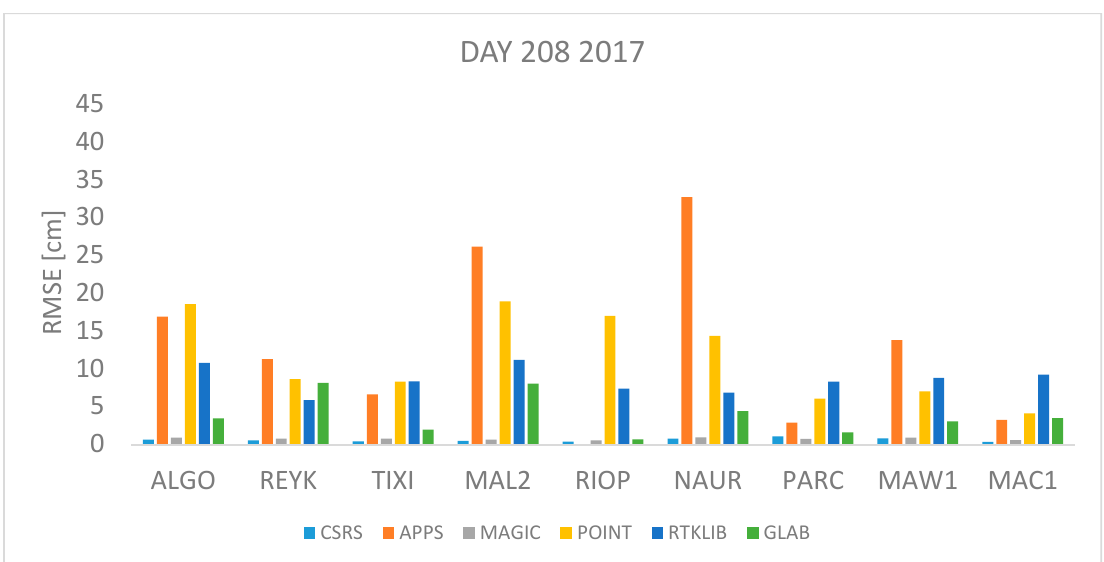
Figure 6. RMSE in centimeters for day 208 2016.